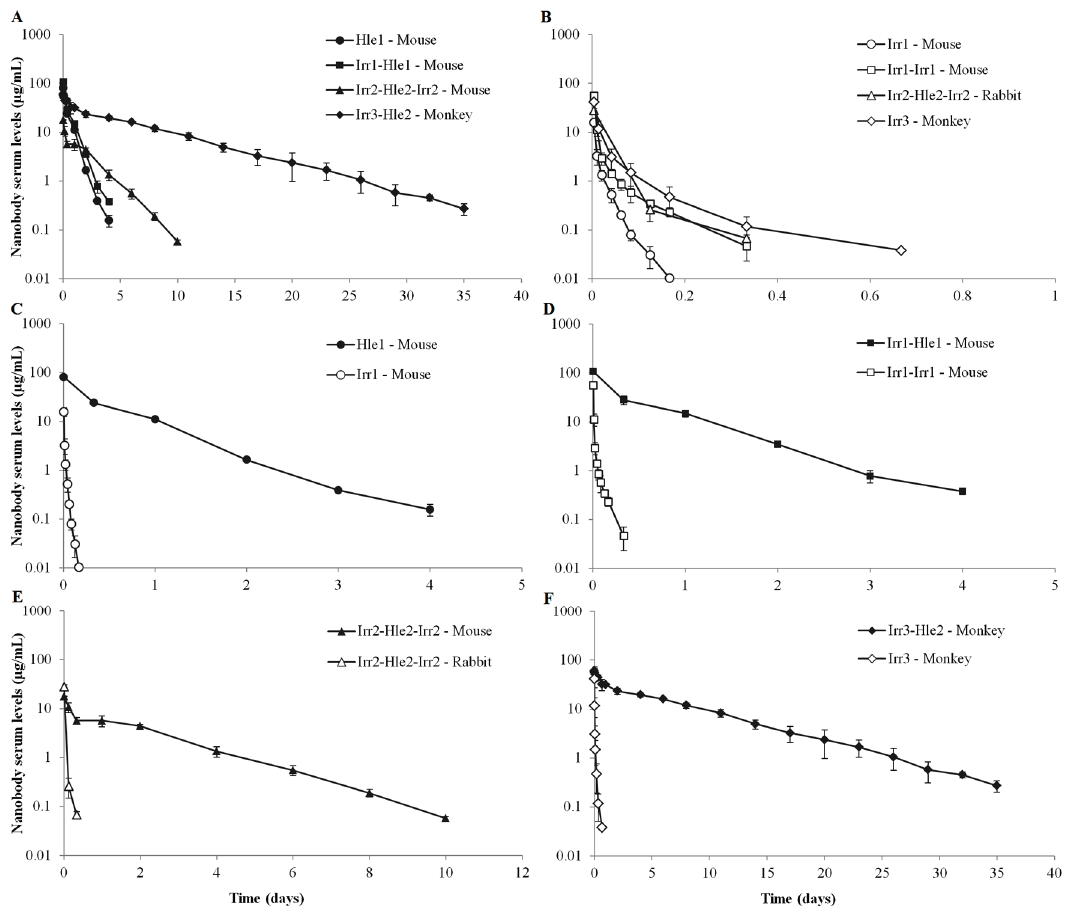
Figure 1. Mean observed (n = 3*; ±standard deviation) serum concentrations (µg/mL) in function of time (days) of seven Nanobodies tested in mice, rabbits or cynomolgus monkeys after single intravenous (i.v.) administration (semi-log scale). Panels ( A , B ) versus ( C – F ) represent the same dataset, plotted differently for interpretation purposes. For clarity, anti- albumin half-life extended Nanobodies (( A ); Filled symbols) are plotted on a separate time- scale than non-half-life extended Nanobodies (( B ); Open symbols). The impact of half-life extension on monomeric ( C ) and dimeric ( D ) Nanobodies (Hle1 vs . Irr1 and Irr1-Hle1 vs . Irr1-Irr1, respectively) tested at a fixed dose of 100 µg in mice is shown. The necessity for high affinity of an anti-albumin Nanobody (Irr2-Hle2-Irr2) for the respective species albumin is shown for mice (Table 1, dissociation constant K D = 180 nM; 1.2 mg/kg dosing) versus rabbits (no albumin binding; 2.5 mg/kg dosing) in ( E ). The impact of half-life extension by linking an anti-albumin Nanobody (Hle2) to an irrelevant Nanobody (Irr3) tested in cynomolgus monkeys (2 mg/kg) is shown ( F ). * Except for Irr3 after 16 hours (n = 1) and Irr3-Hle2 after 32 and 35 days (n = 2) post administration, due to values below the limit of